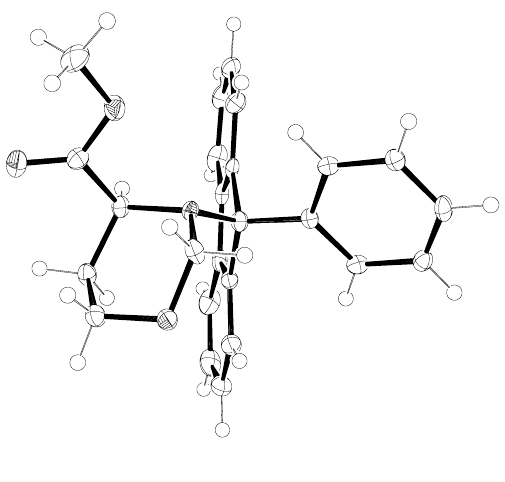
Figure 12. The crystal structure of compound 79